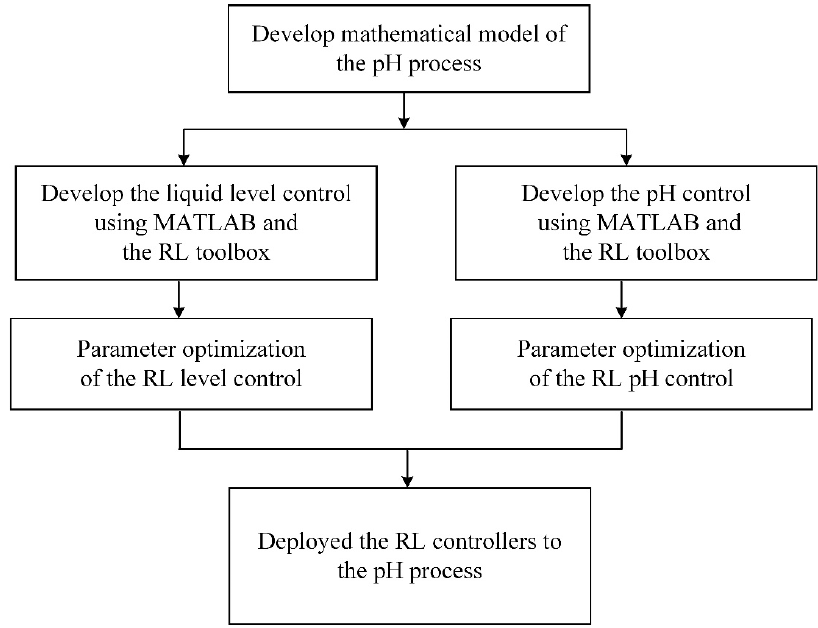
Figure 4. A framework for developing reinforcement learning control for the pH process.